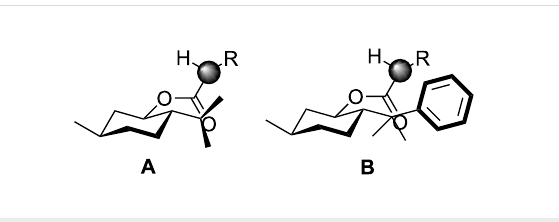
Figure 6: Discrimination of diastereomeric faces in the menthol substi- tuted radical A and in the 8-phenylmenthol substituted radical B